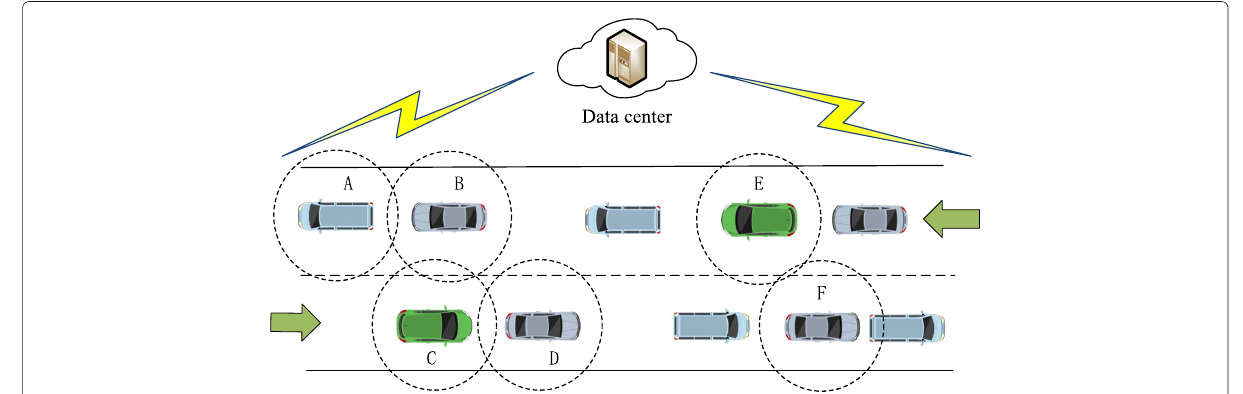
Fig. 1 Computational offloading scenario in a vehicle ad hoc